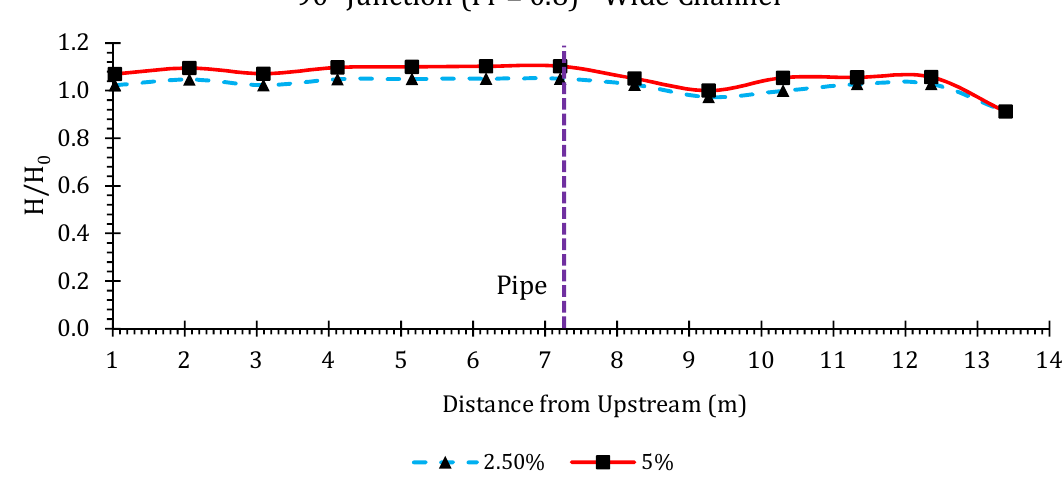
Figure A3. Water height ratios in a 90° junction for Fr = 0.8 in the wide channel.